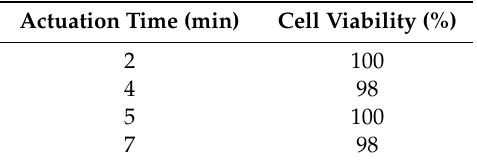
Table 1. Cell viability as a function of the actuation time of the device.